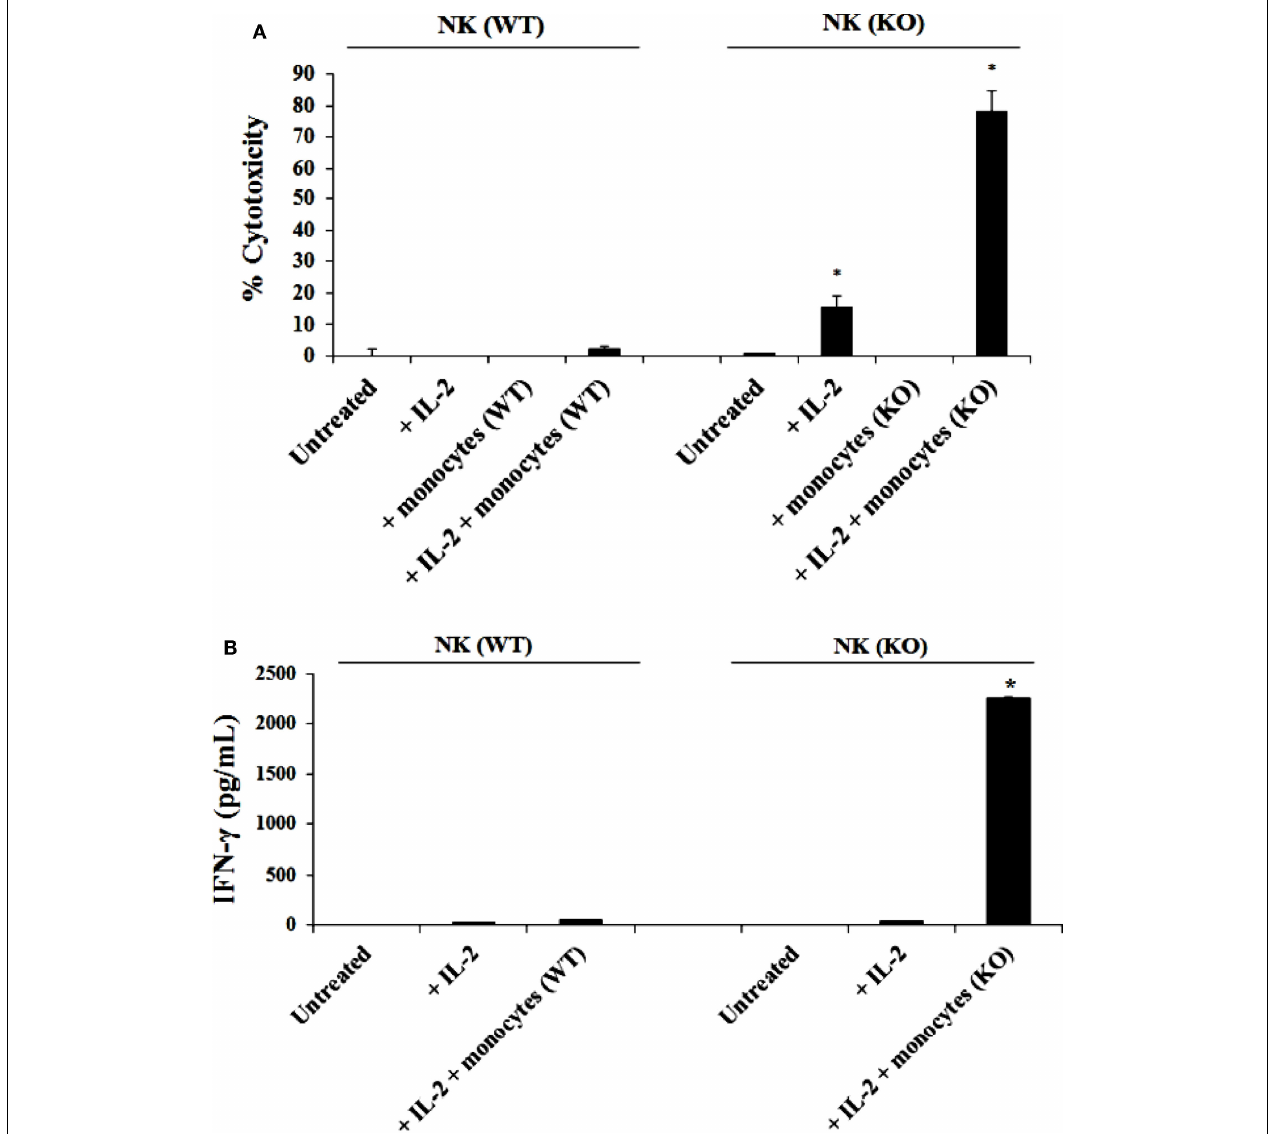
FIGURE 2 | IL-2 activated NK cells from Cox-2 flox/flox ;LysM Cre/ + mice cultured with autologous monocytes lysed YAC-1 cells and secreted high levels of IFN- γ as compared to NK cells from control littermates in the presence and absence of autologous monocytes . NK cells obtained from control mice or Cox-2 flox/flox; LysM Cre/ + mice were left untreated or treated with IL-2 (1 (cid:2) 10 4 U/million) in the presence or absence of autologous monocytes for 7days. Afterward, the cytotoxic function of NK cells against YAC-1 cells was determined using a standard 4h 51 Chromium release